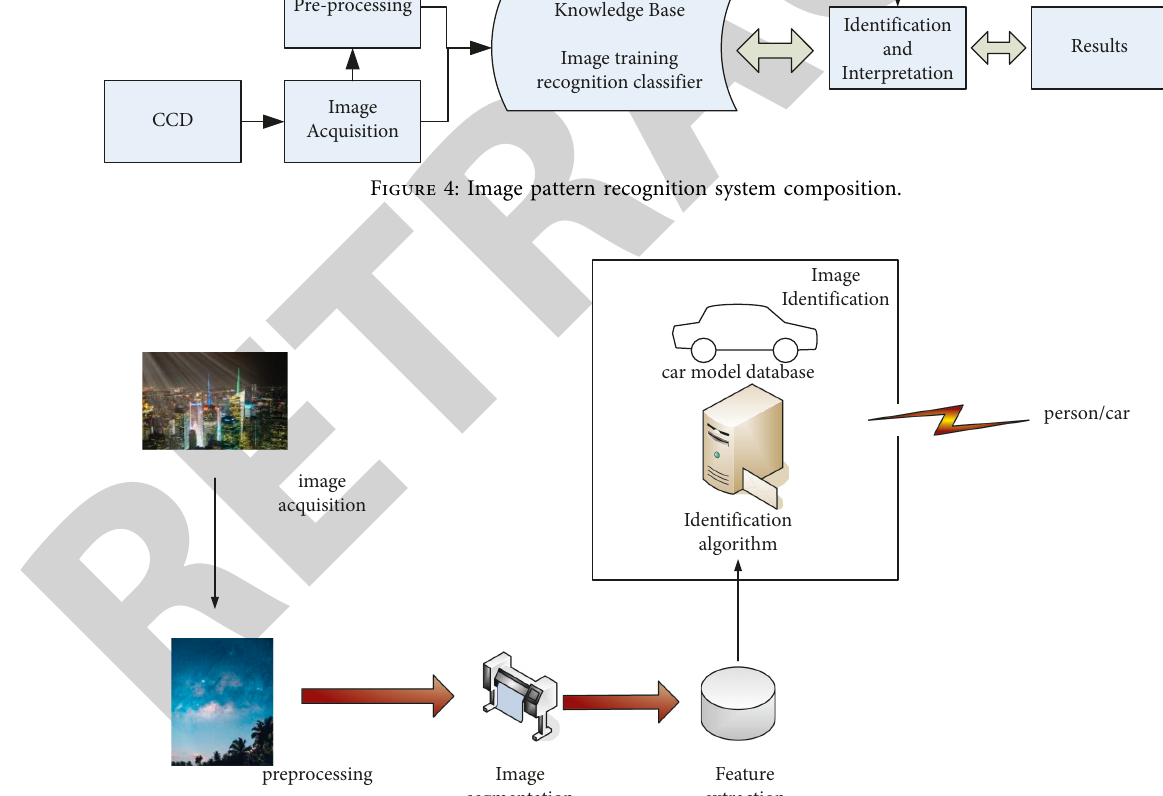
Figure 3: Algorithm detection